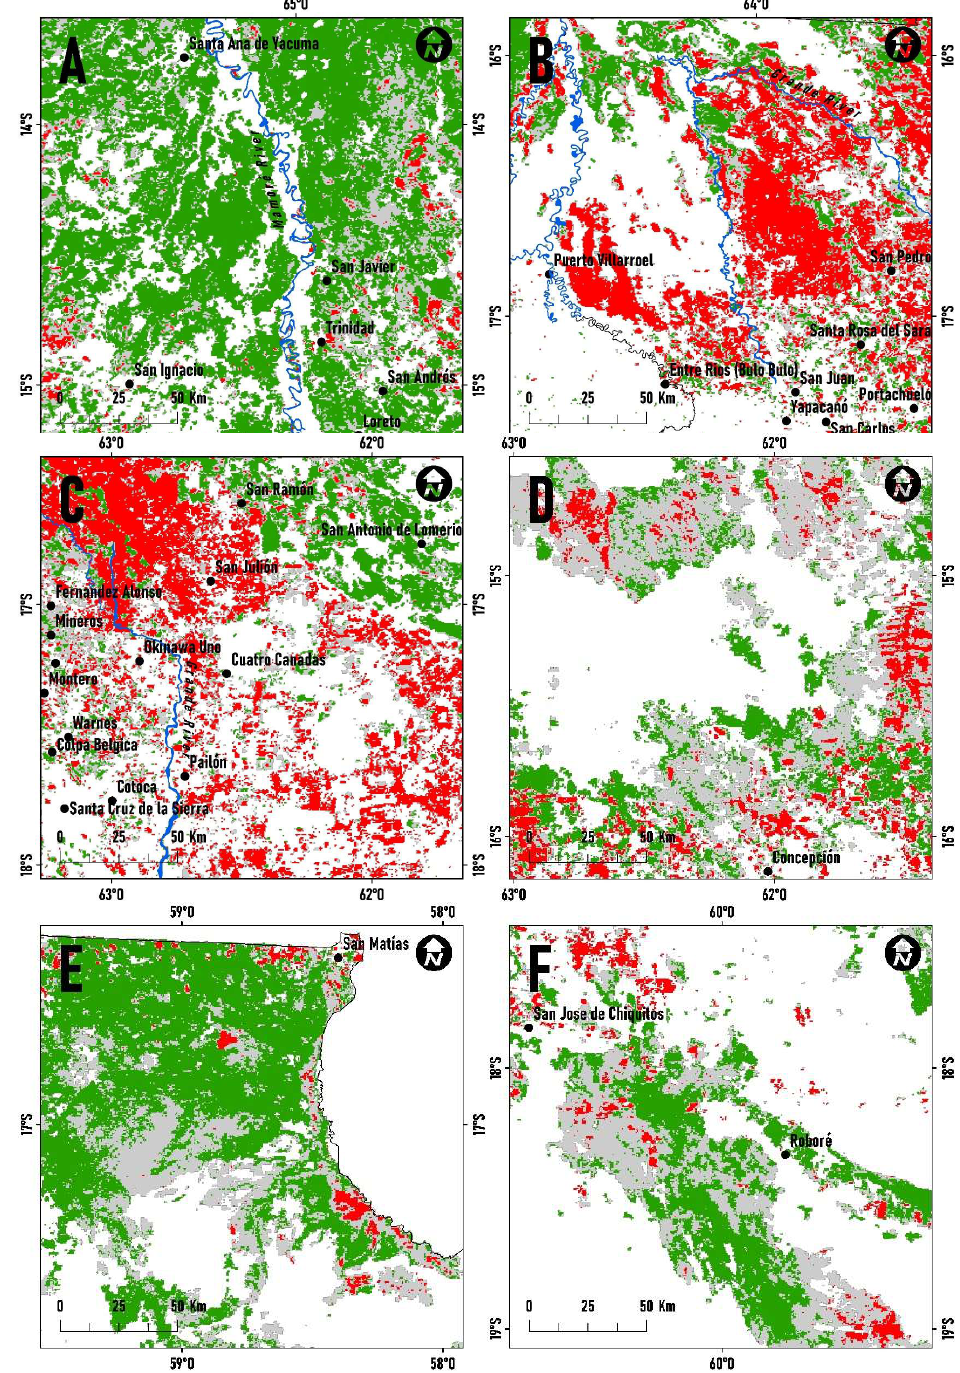
Figure 4. Visualization of areas with significant increasing (green) and decreasing (red) trends in ( A ) Mamoré River, ( B ) West of the Grande River, ( C ) East of the Grande River, ( D ) Concepción, ( E ) San Matías, and ( F ) San José-Roboré. Areas in gray have no significant trend.